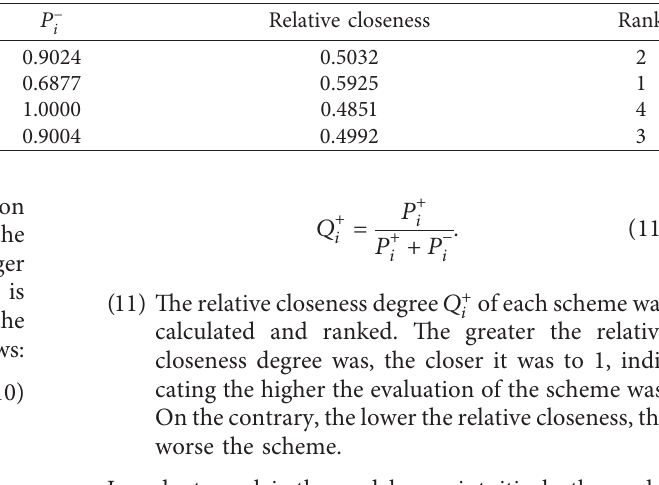
Table 5: Comprehensive evaluation and ranking table of hydrogen production technical